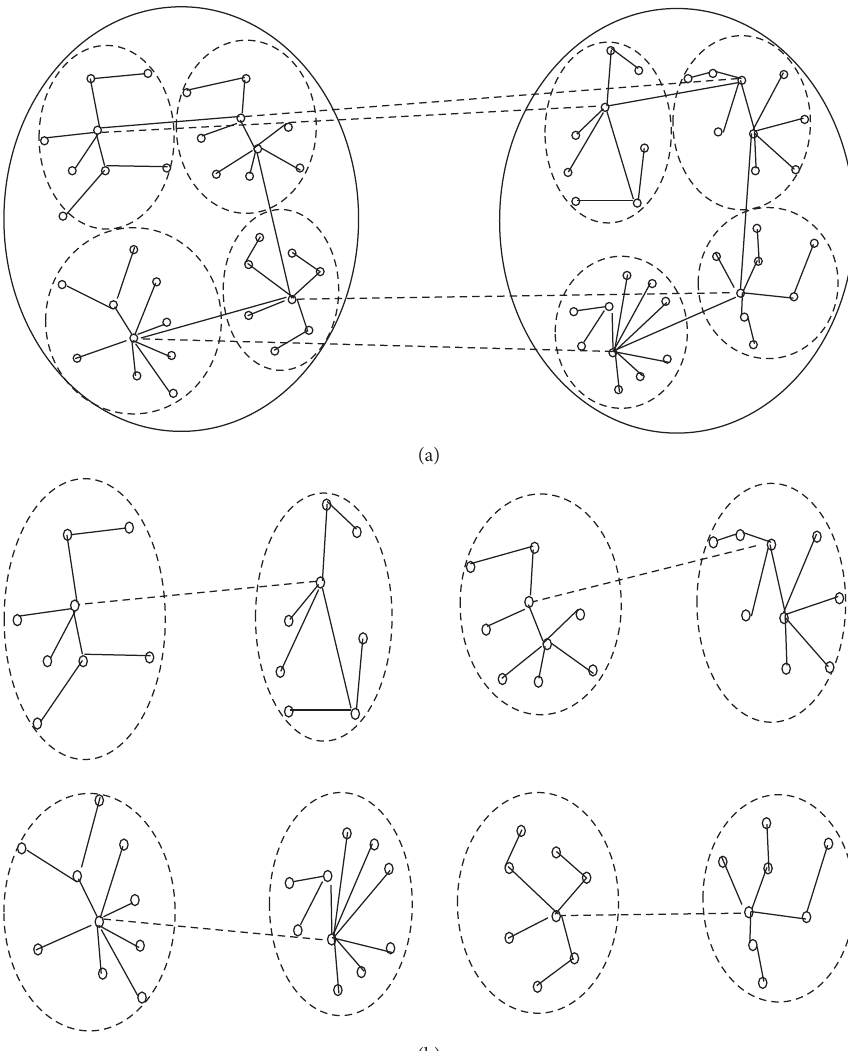
Figure 1: (a): Cluster the network and identify similar communities. (b): User identification in similar